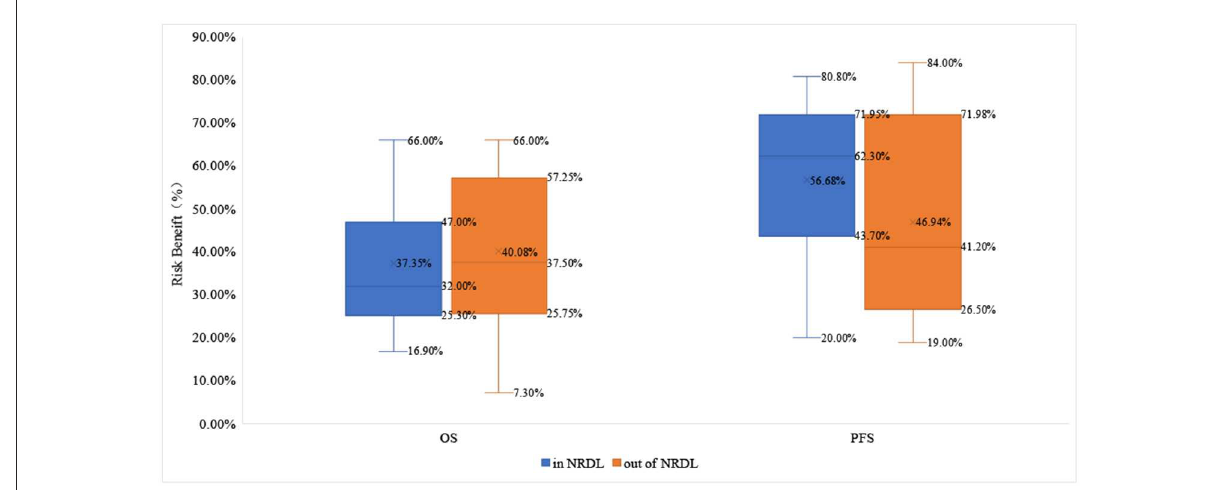
FIGURE2 The risk benefit in OS and PFS of drugs in and out of NRDL.